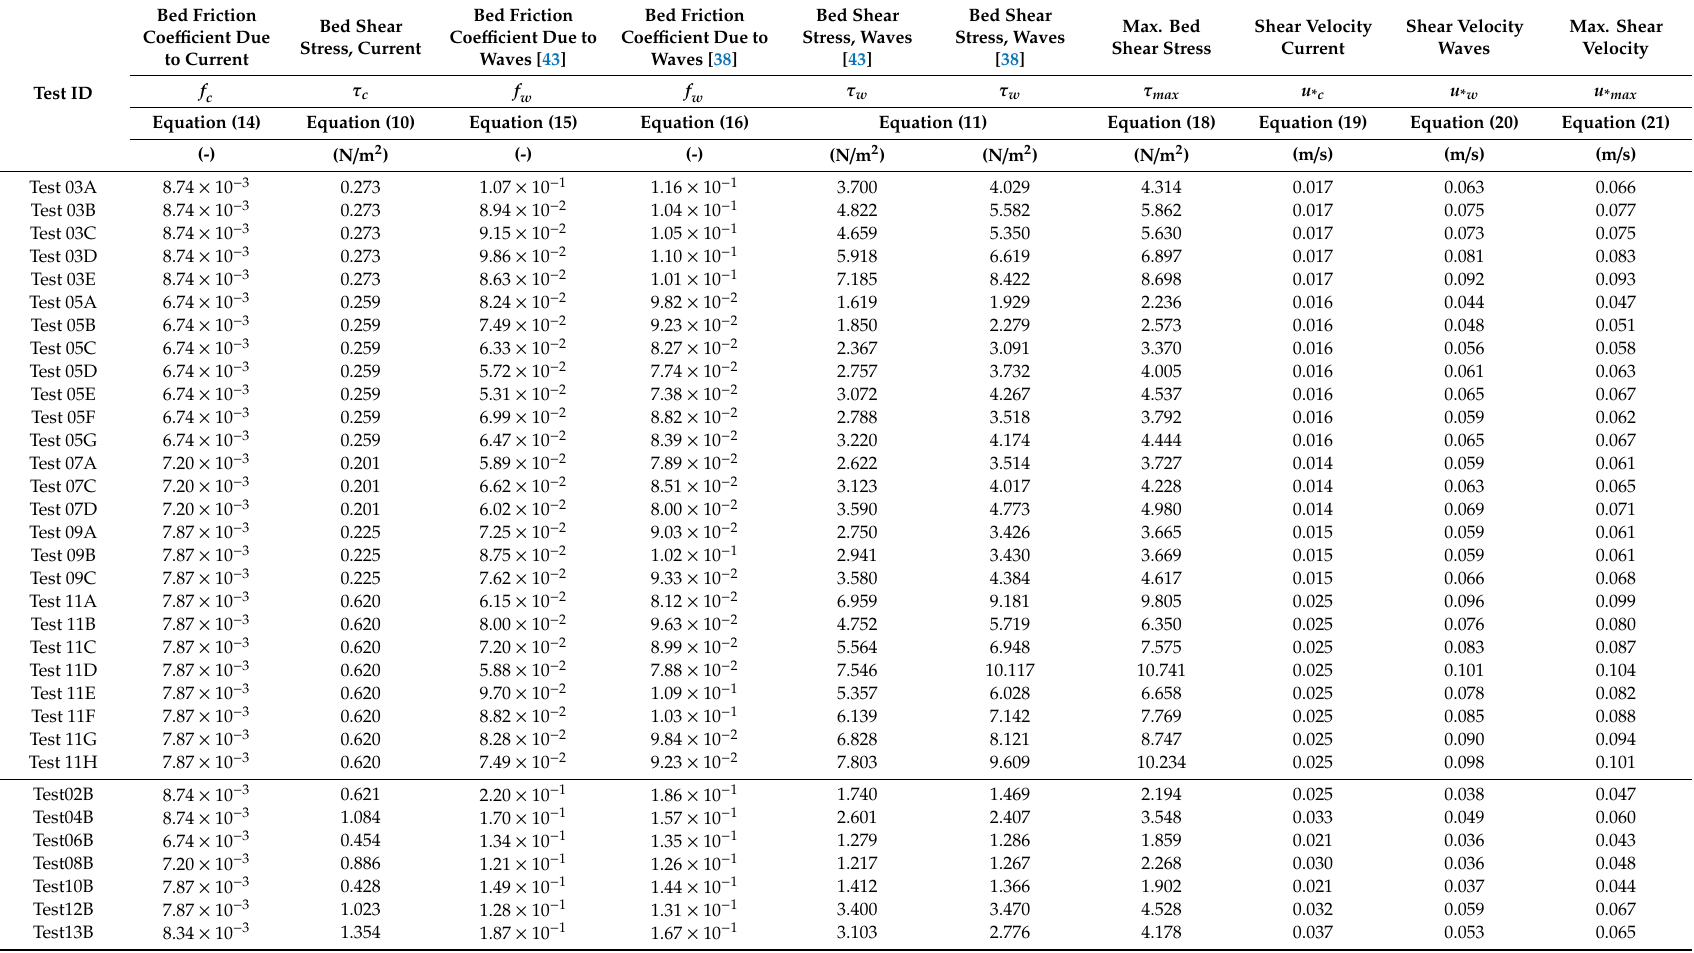
Table 3. Bed shear stress analysis